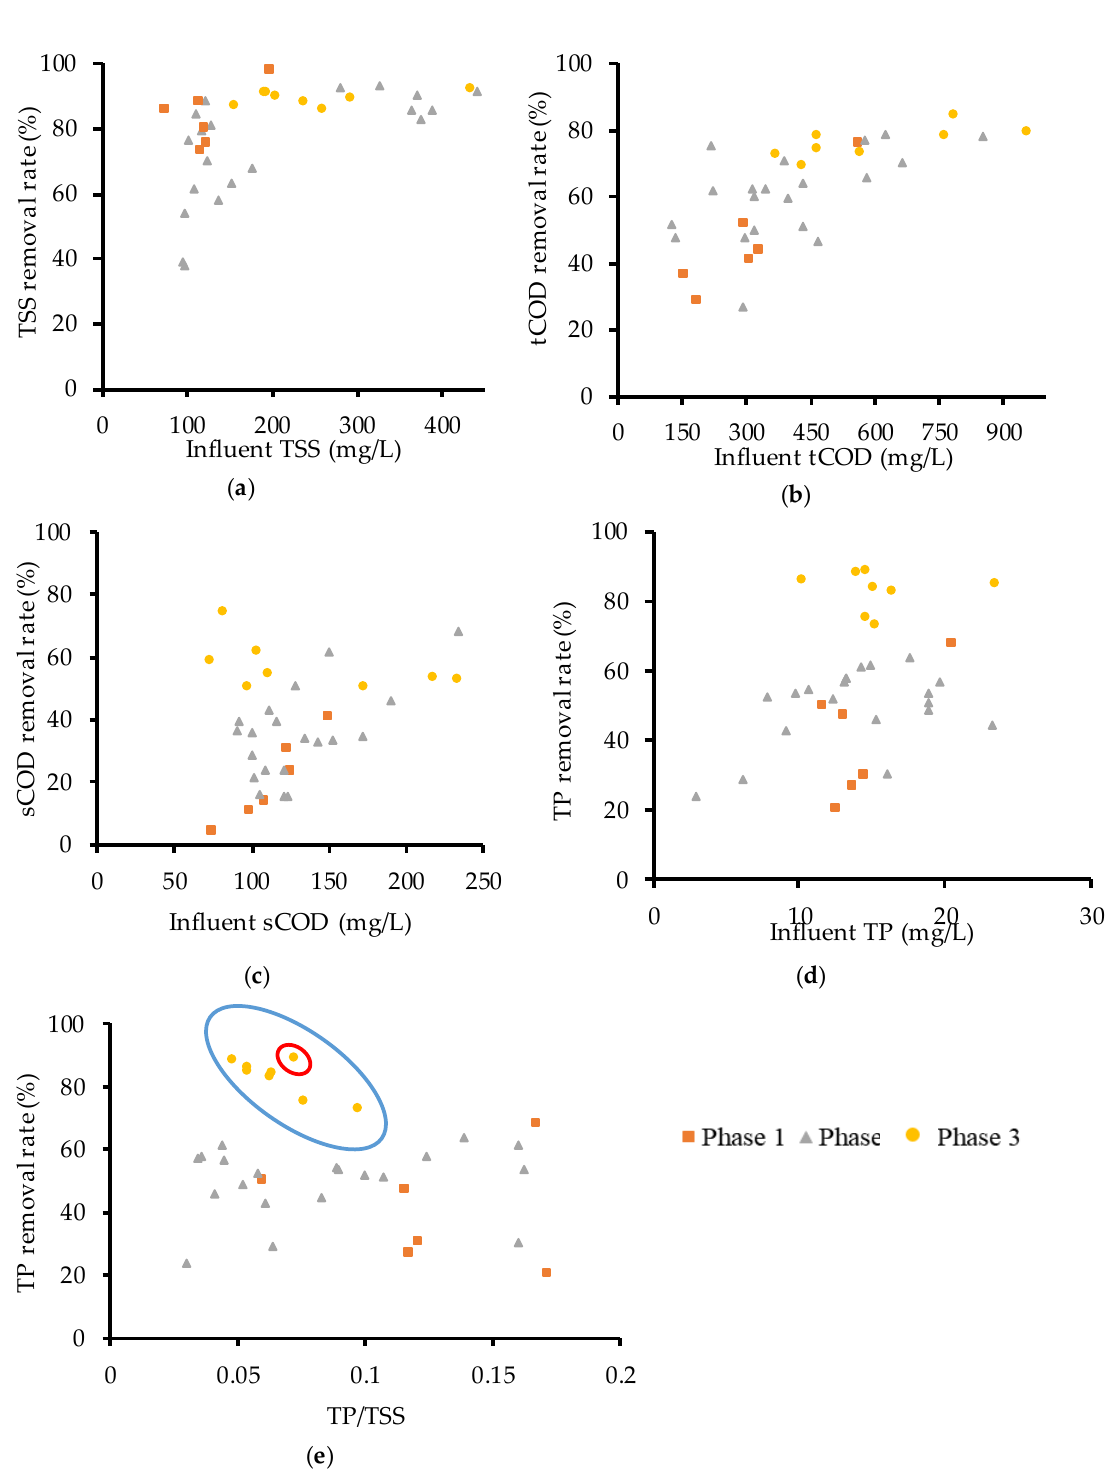
Figure 4. Effect of influent characteristics on removal rate: ( a ) the effect of TSS concentration, ( b ) the effect of total COD, ( c ) the effect of soluble COD, ( d ) the effect of TP concentration, and ( e ) the effect of TP/TSS ratio.